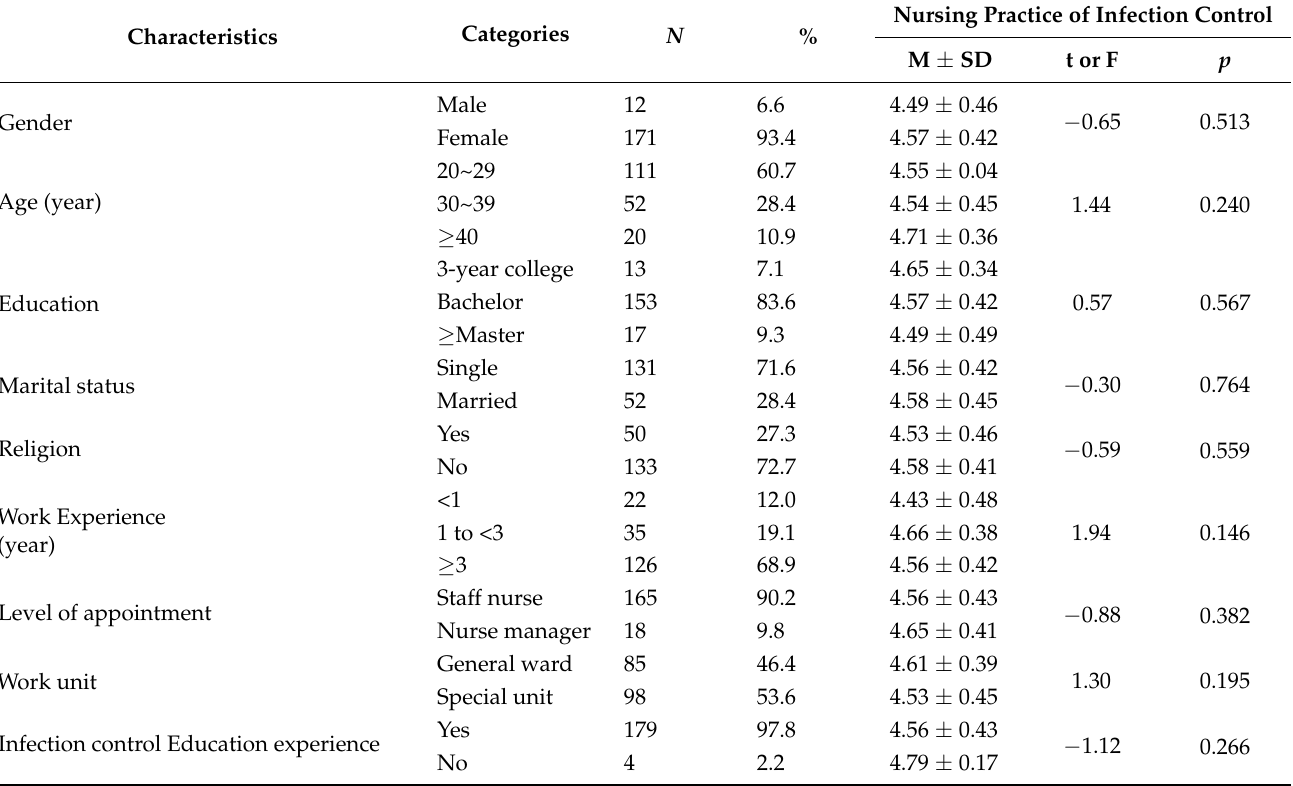
Table 1. Nursing Practice of Infection Control according to Participant Characteristics ( N =